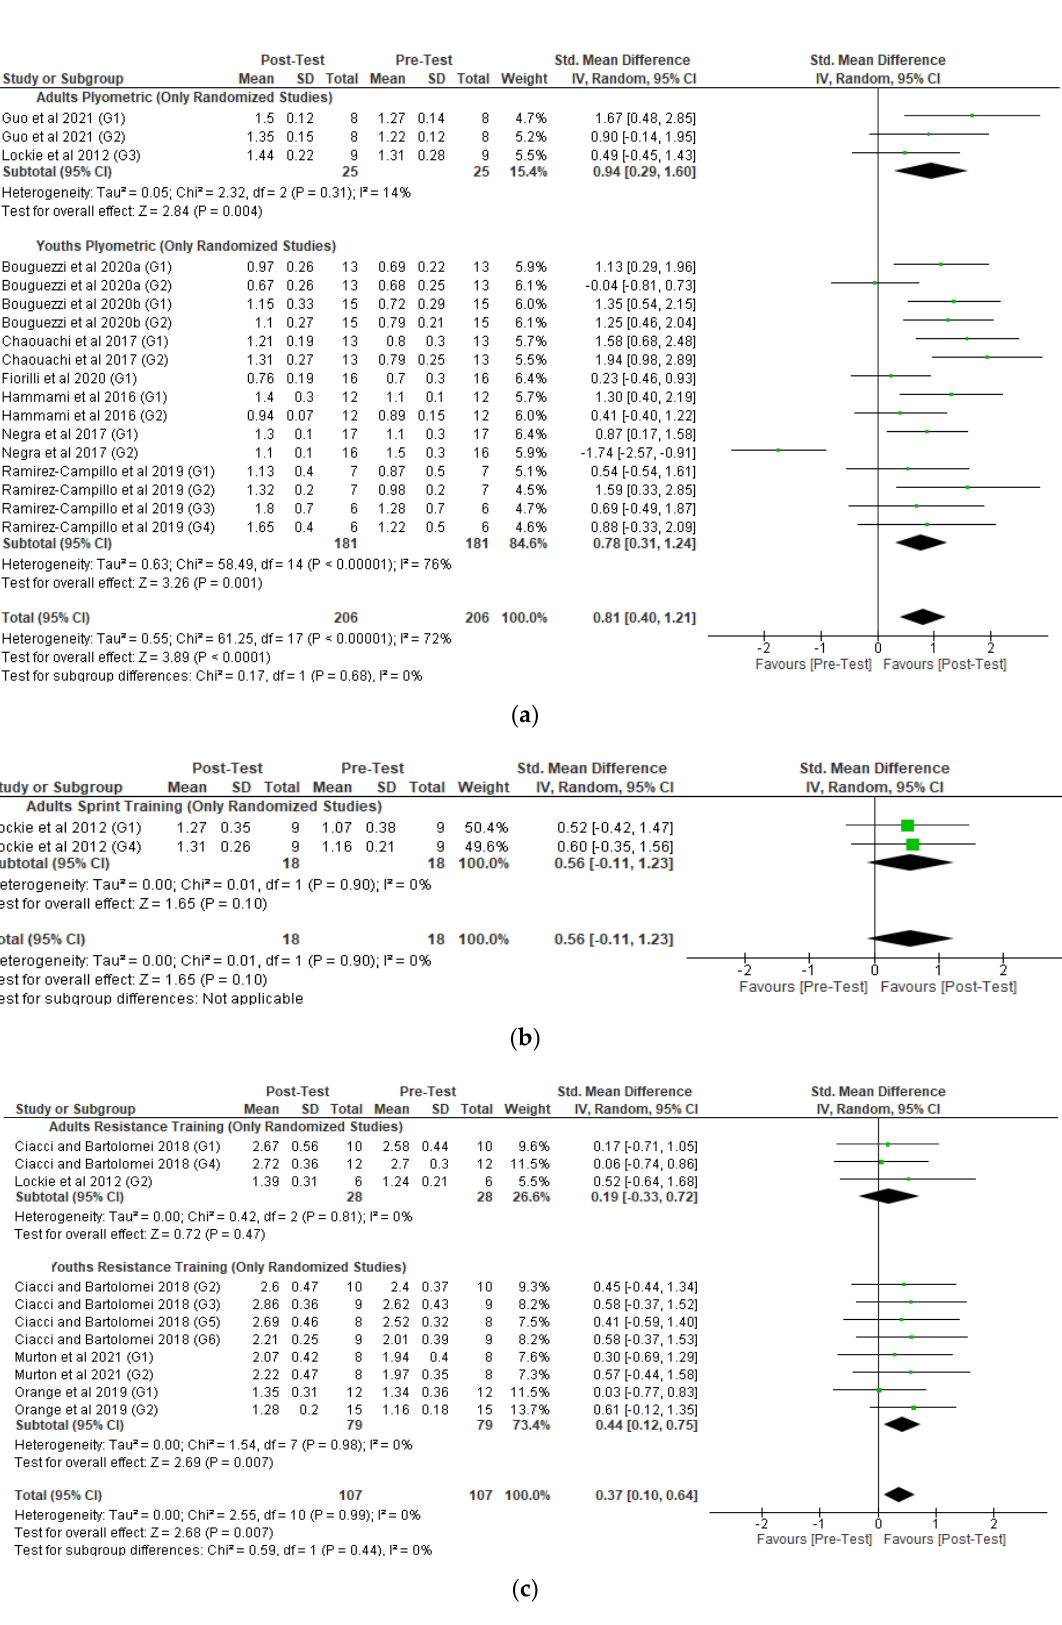
Figure 3. Forest plot of the overall standardized mean difference [95% CI] for each randomized study (the size of the green dot corresponds to the weight of the study within the meta-analysis), without a control group, with a ( a ) plyometric training intervention, ( b ) sprint training intervention, and ( c ) resistance training intervention included in the